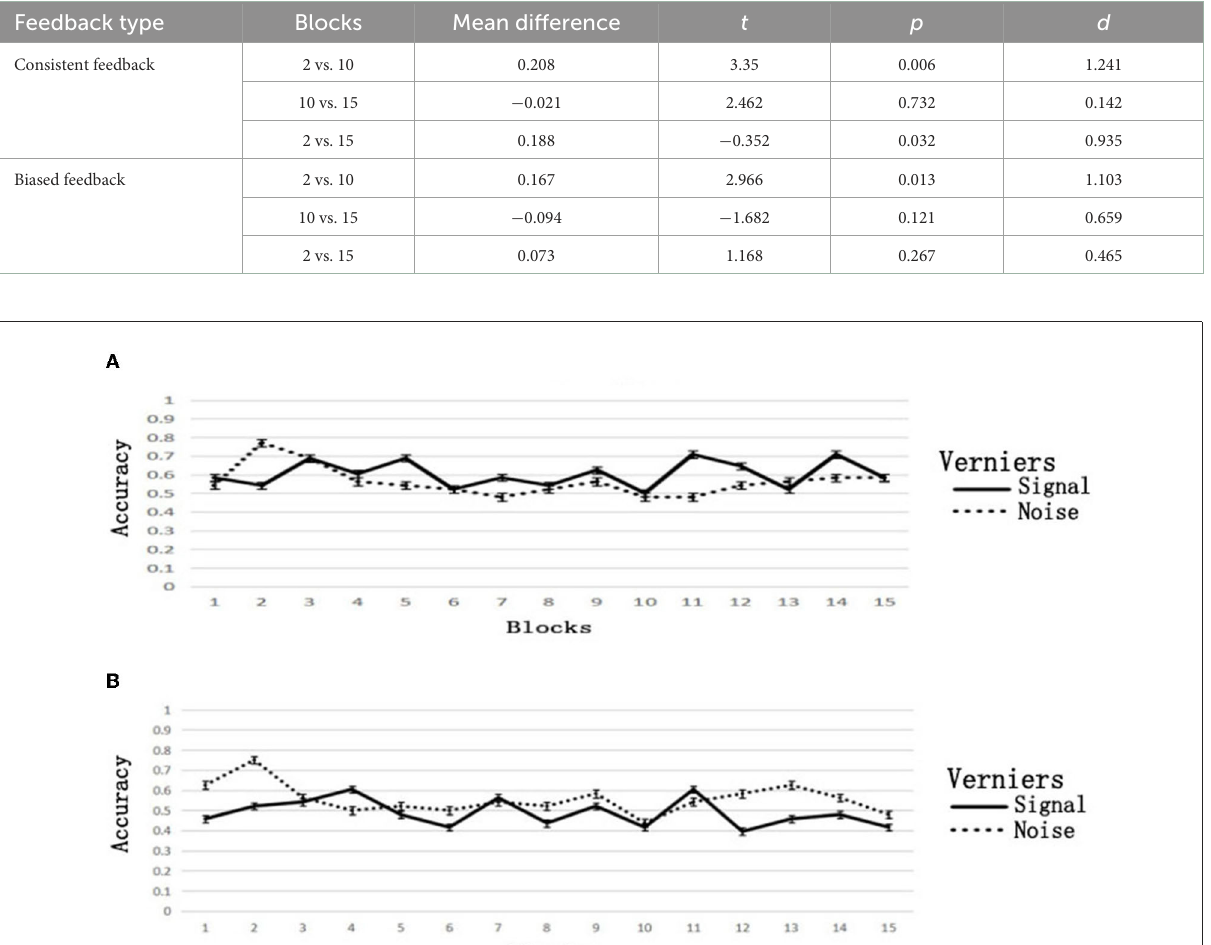
TABLE 3 T -tests of block feedback without guidance.